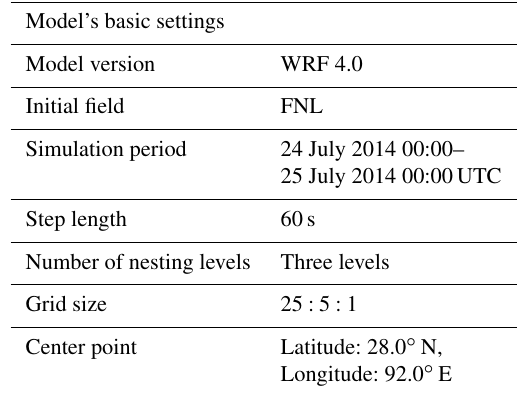
Table 2. Model’s basic